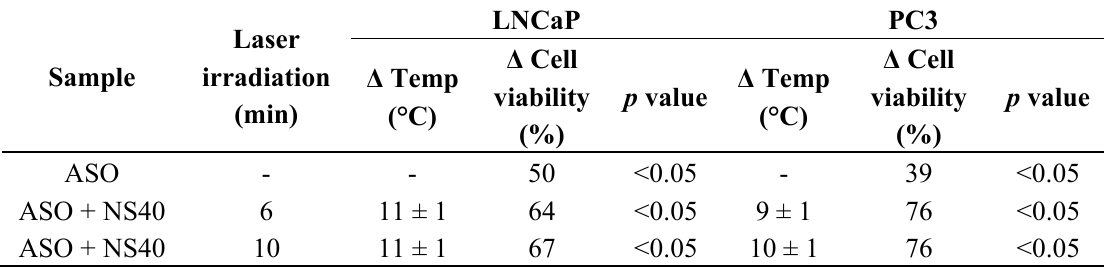
Table 2. Summary of the decrease in cell viability and changes in temperature for photothermal experiments with 40 nm gold nanoshells and 100 nm, as in Figure